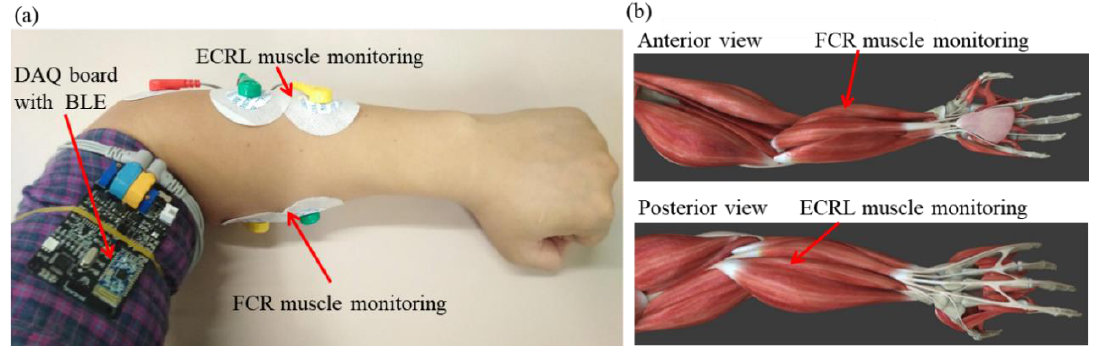
Figure 2. Monitoring of muscular activities: ( a ) monitoring of the extensor carpi radialis longus (ECRL) and the flexor carpi radialis (FCR) muscles; ( b ) muscle distribution.